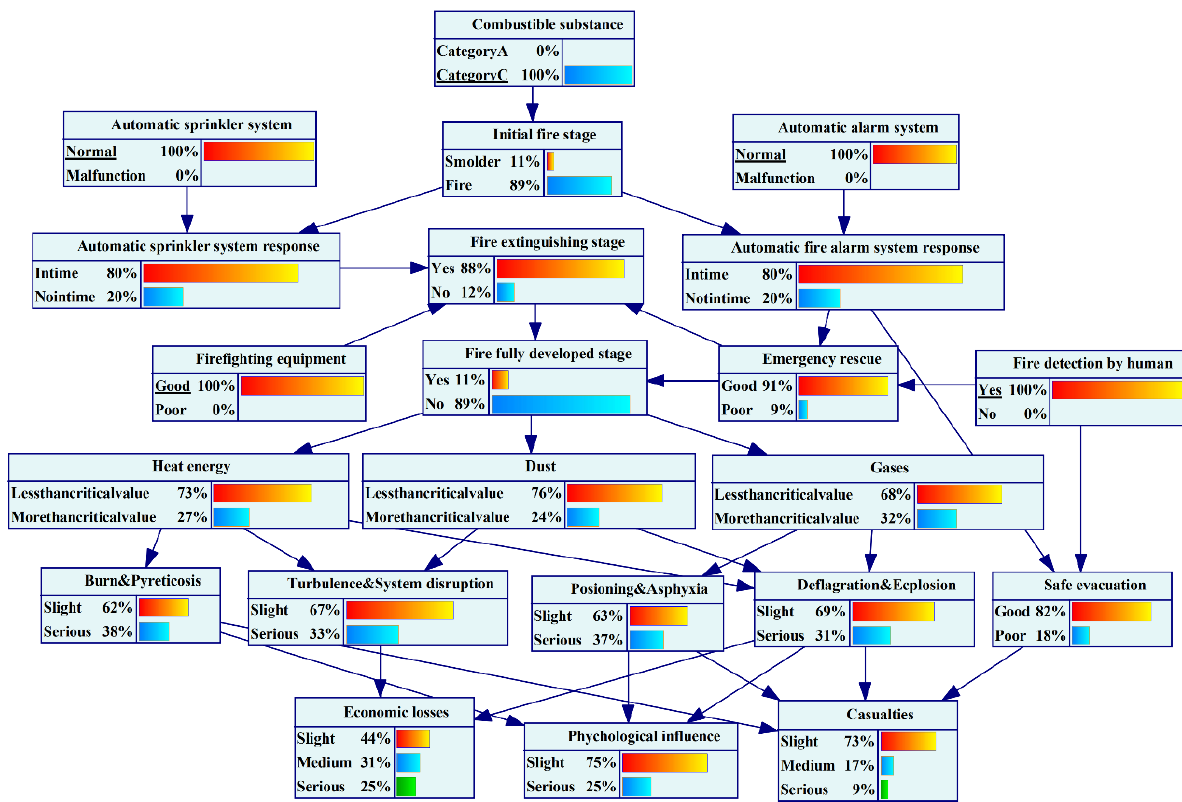
Figure 12. Scenario results with effective fire safety barriers.